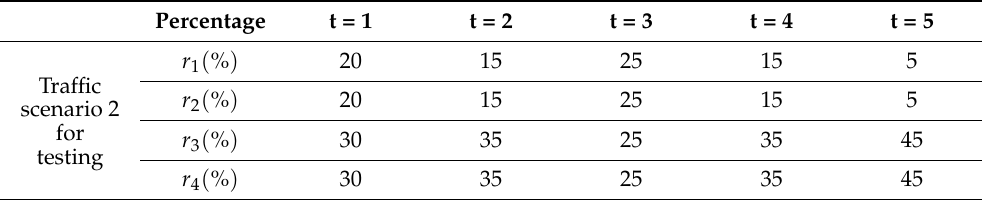
Table 14. Design of traffic scenario 2 for testing: allocation of vehicles in each